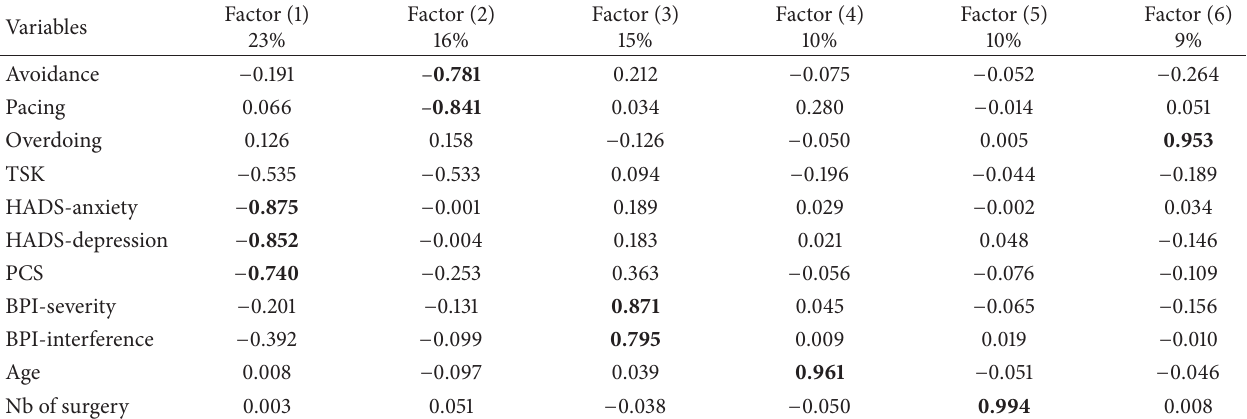
Table 2: Factor loadings of the Principal Components